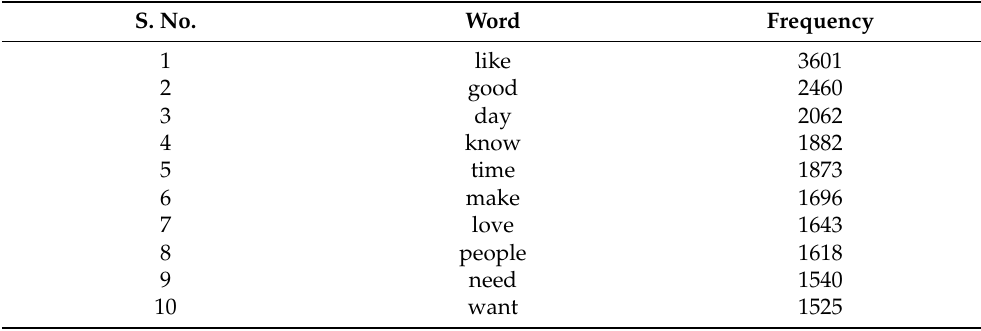
Table 3. Most frequent 10 words that appear in the dataset. S.